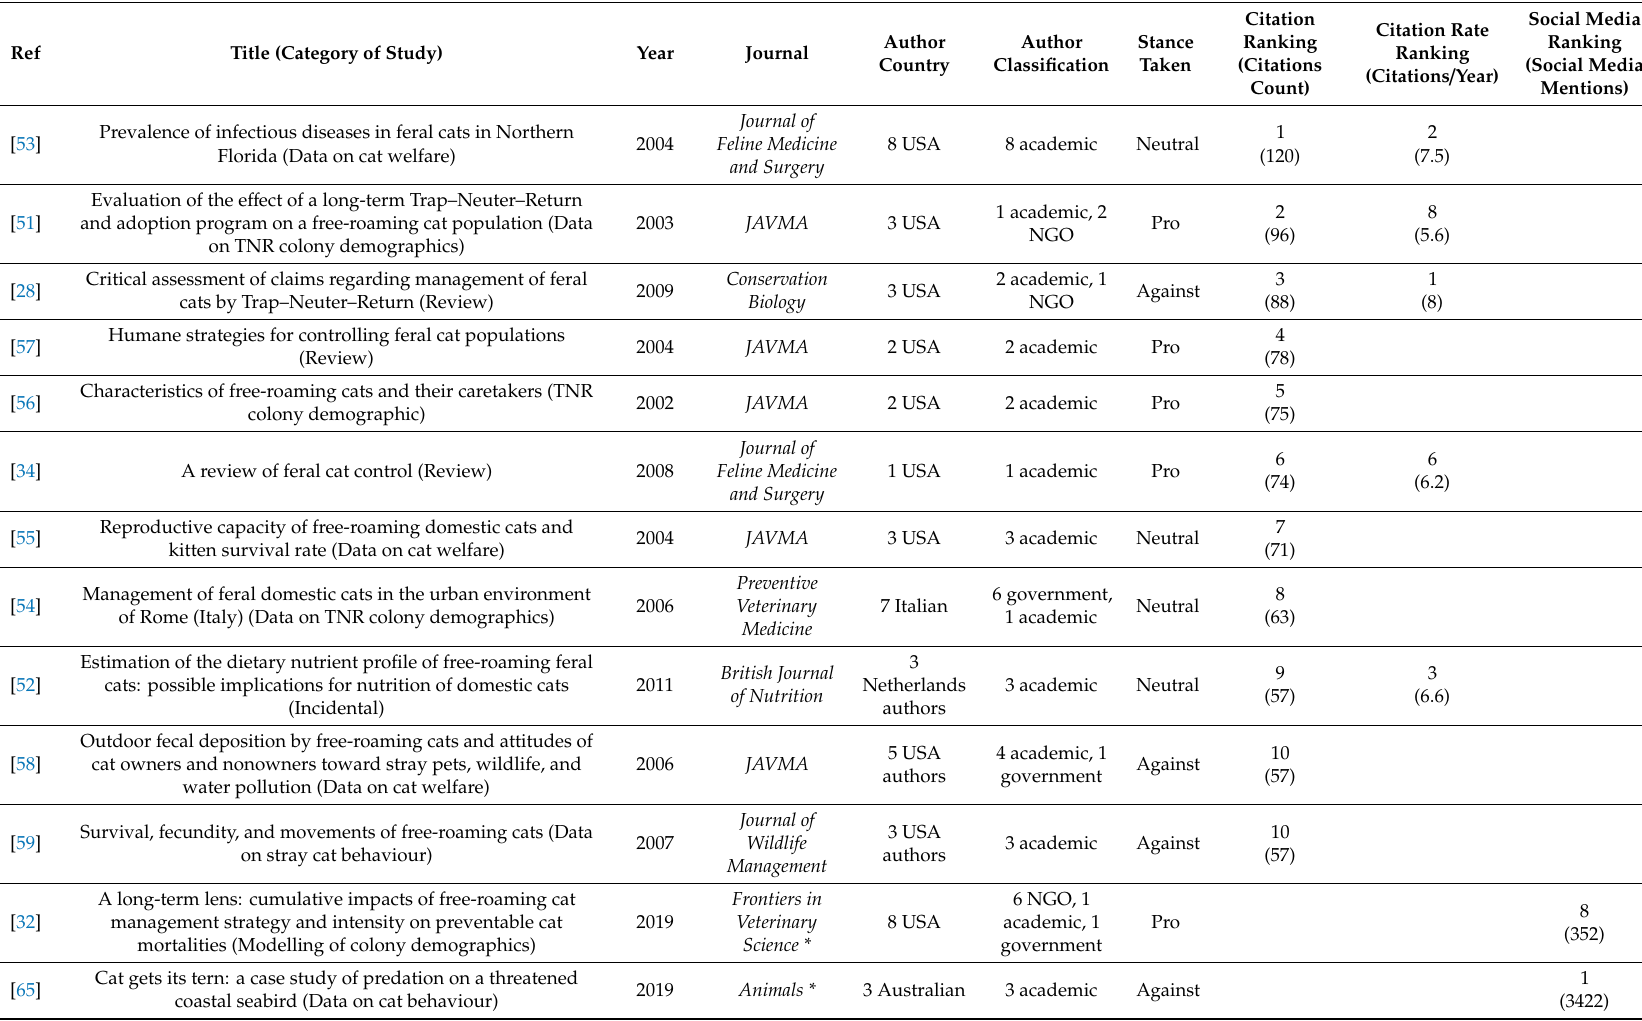
Table 4. The top TNR papers between 2002–2019 ranked on citations (top 10), citations / year since publication (top 10), or social media mentions (top 10) since